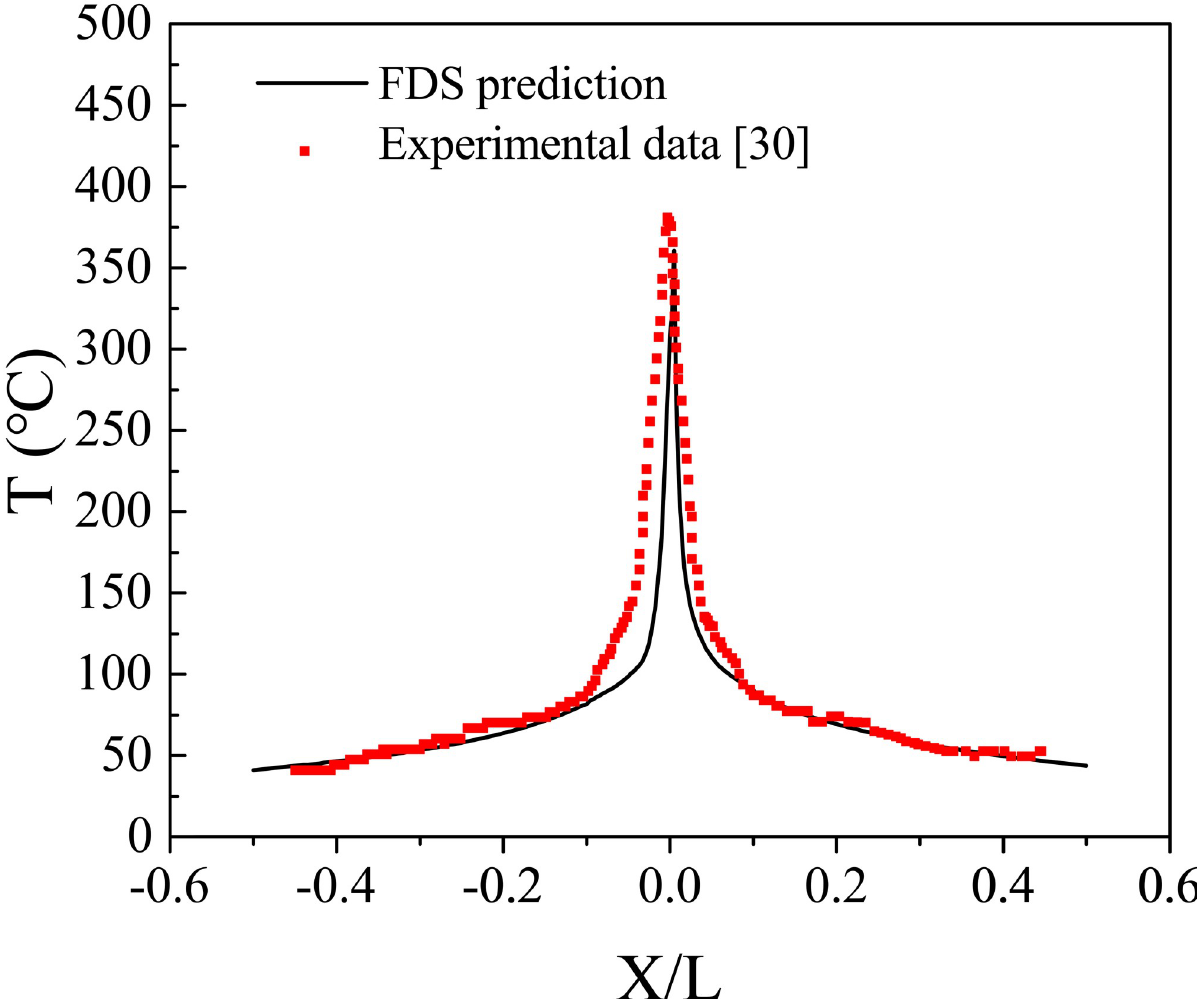
Fig 3. Comparison between FDS prediction and experimental